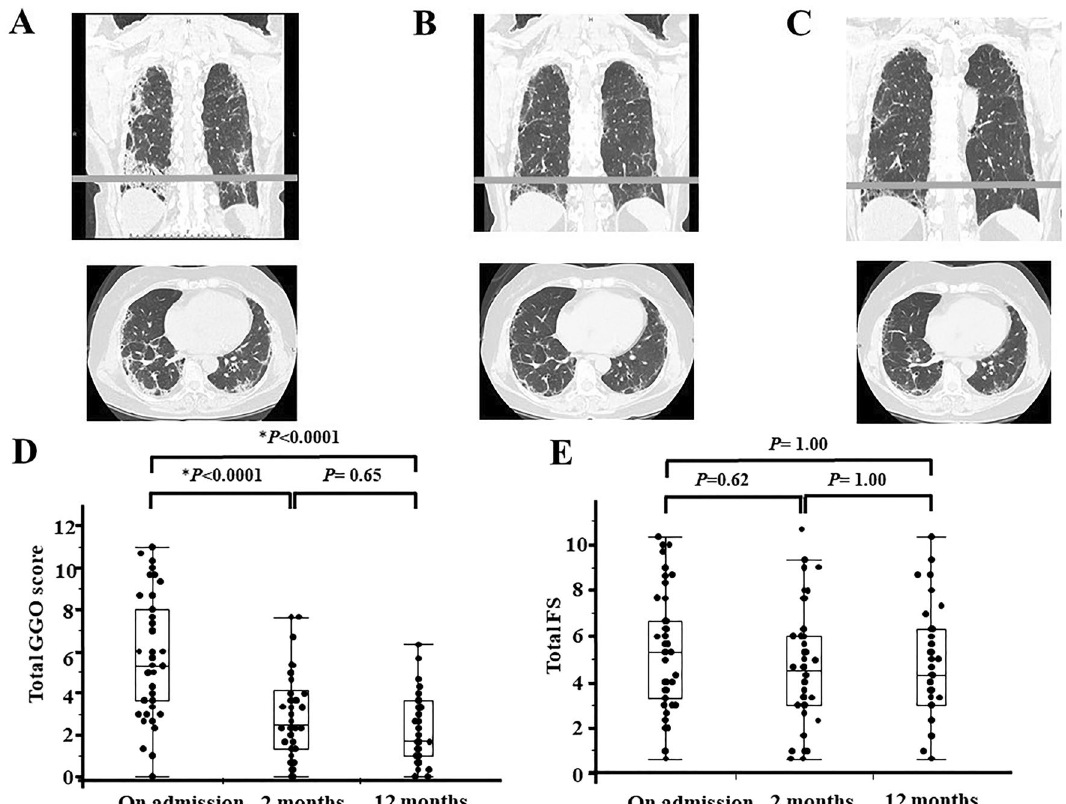
Figure 5. Serial change of chest high-resolution computed tomography findings (HRCT) and HRCT scores in microscopic polyangiitis (MPA)-interstitial lung disease (ILD). ( A ) Typical chest HRCT findings in MPA- ILD before immunosuppressive therapy. ( B ) Typical chest HRCT findings in MPA-ILD 2 months after immunosuppressive therapy. ( C ) Typical chest HRCT findings in MPA-ILD 12 months after immunosuppressive therapy. Upper image is a coronal section and the lower image is an axial section. The gray lines are located 1 cm above the diaphragm. ( D ) Total ground-glass opacity (GGO) score significantly decreased from the initial measurement to 2 months after starting immunosuppressive therapy ( P < 0.0001) and sustained the same levels from 2 to 12 months. ( E ) There were no significant differences in total fibrosis score (FS) between the initial measurement and those at 2 and 12 months. Statistical analysis was carried out with the Skillings–Mack test and a Dunn’s post hoc test for multiple comparison. *P <